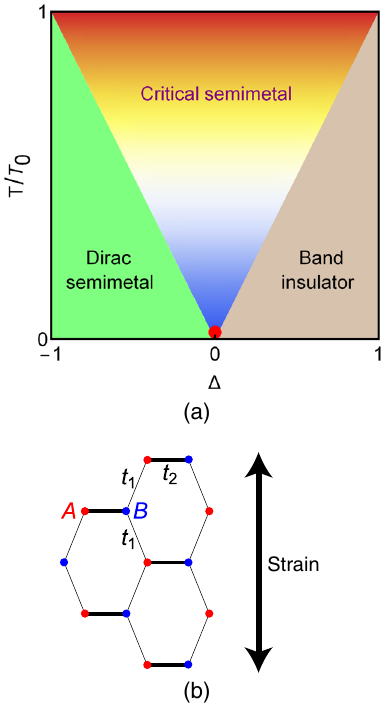
FIG. 1. (a) Schematic representation of the quantum critical fan at finite temperature associated with the direct transition between a two-dimensional Dirac semimetal and a symmetry-preserving b Þ . The signatures of the critical band insulator, with T 0 ∼ v 2 / ð k B excitations, described by an anisotropic semimetal [ H ð k ; 0 Þ from Eq. (1)], get gradually washed out as the temperature is increased and lattice effects set in at high temperature ( T ∼ T 0 ). The zero temperature quantum critical point in the noninteracting system, located at Δ ¼ 0 , is represented by the red dot. The critical regime can also be exposed by frequency and magnetic field (see text). The scaling of physical observables inside the critical fan, within the Dirac semimetal, or within the band insulator side of the transition is reported in Table I. (b) Hopping pattern in a uniaxially strained honeycomb lattice. Strong (weak) hopping amplitudes are represented by thick (thin) lines. The sites on the two sublattices are shown in red ( A ) and blue ( B ). The anisotropic semimetal is realized when t 2 ¼ 2 t 1 .